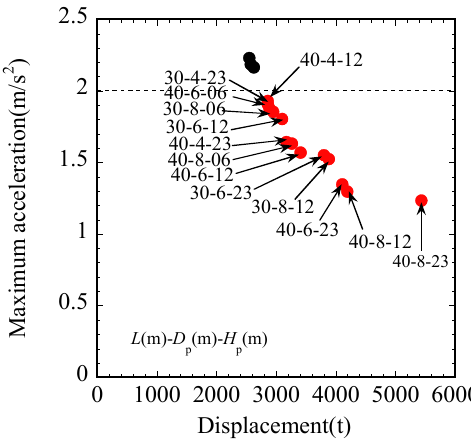
Fig. 14 The maximum horizontal accelerations at hub height under cut-out wind speed conditions and displacements of final selected candidates.